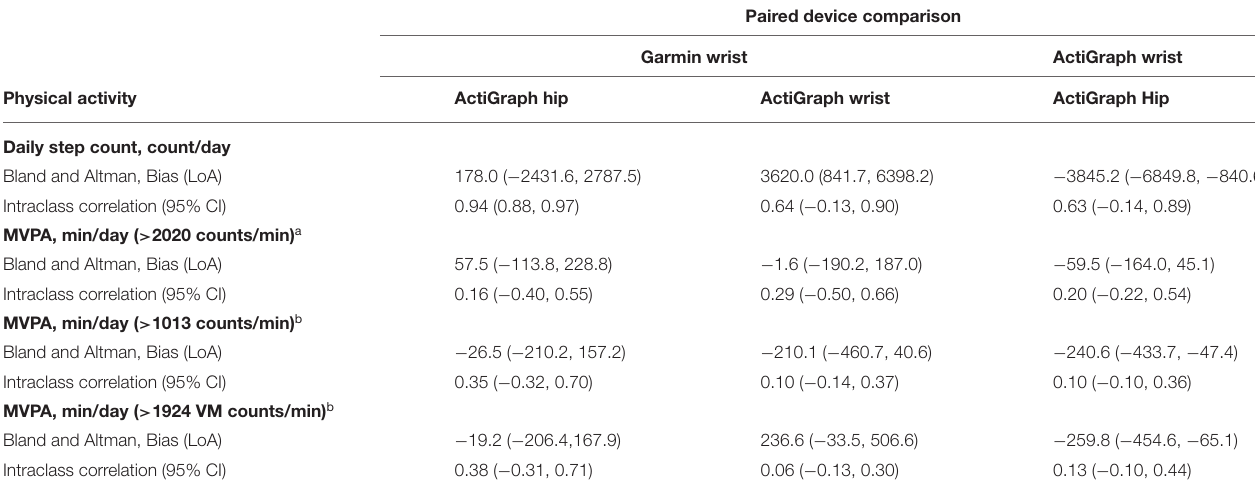
TABLE 3 | Agreement between devices using Bland and Altman and intraclass correlation.